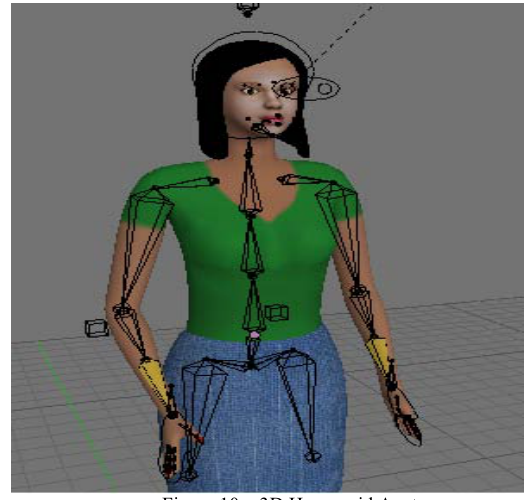
Figure 10 – 3D Humanoid